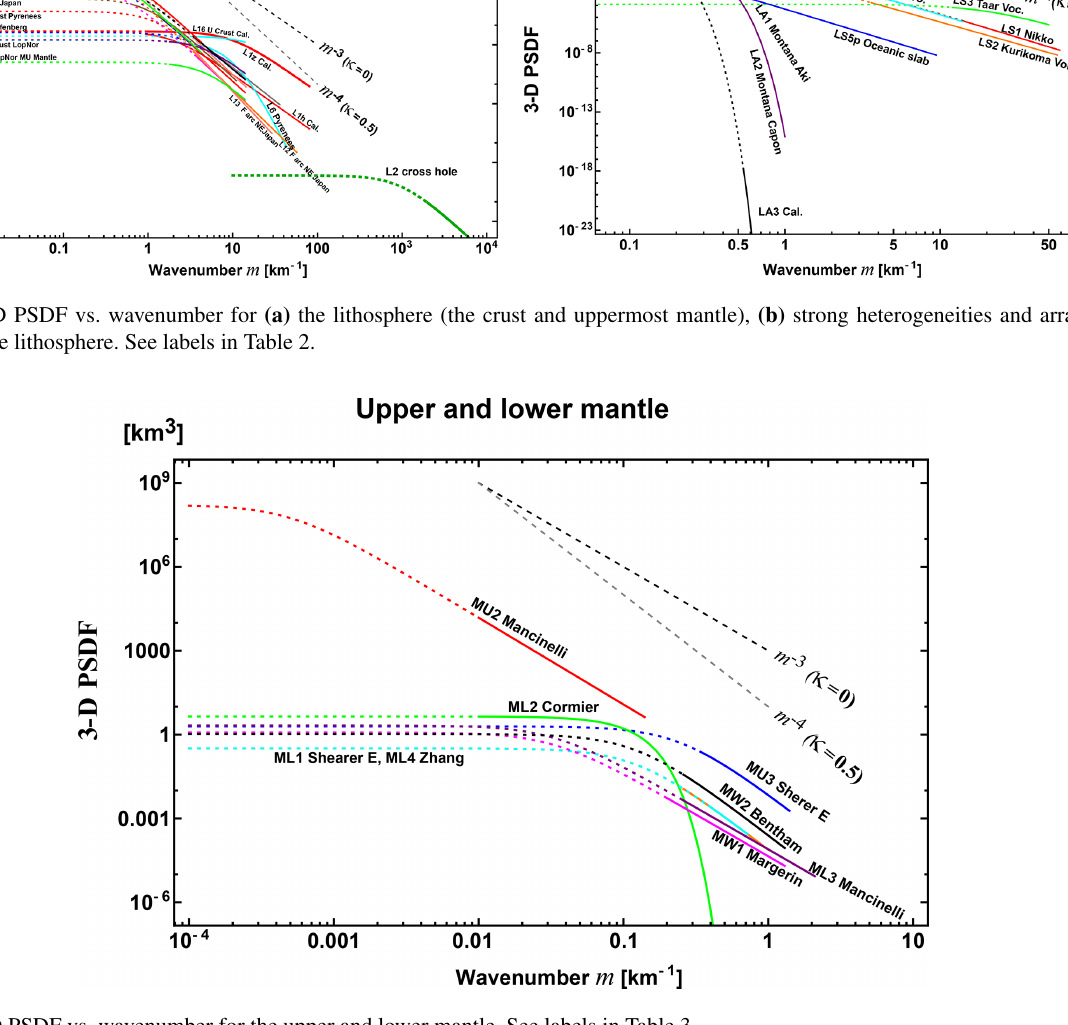
Figure 4. 3-D PSDF vs. wavenumber for the upper and lower mantle. See labels in Table